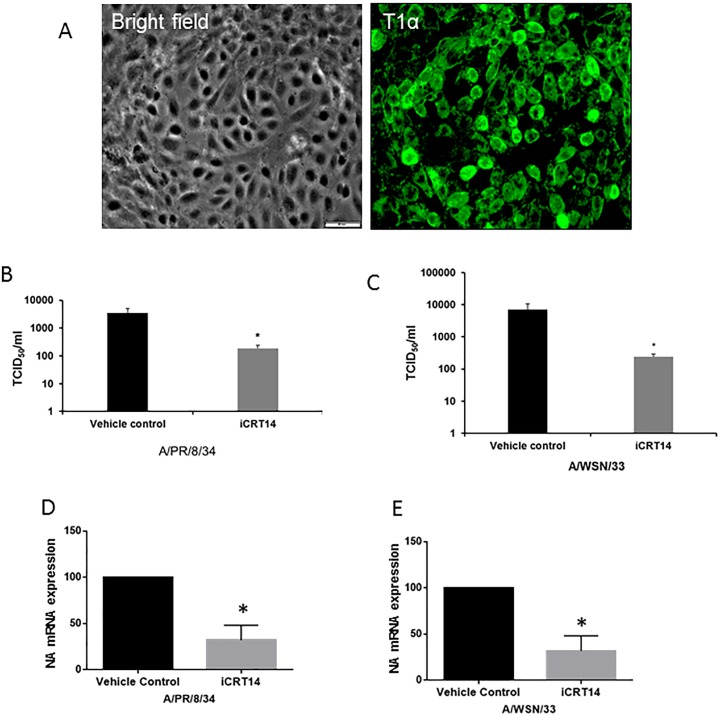
iCRT14 reduces influenza virus infection in primary mouse alveolar epithelial cells (AECs).Mouse AECs were isolated and cultured for 6 days. (A) AECs were immuno-stained with the AEC type I marker T1α and the nuclear dye DAPI. Scale bar = 50 μm. (B-E) AECs were infected with influenza virus A/PR/8/34 or A/WSN/33 at an MOI of 1 for 24 h. The cells were treated with iCRT14 (12.5 μM) or vehicle control 1 h prior to infection. Viral titers in the cell culture medium were determined using the TCID50 assay (B, C). NA mRNA levels in cells were determined by real-time PCR and normalized to GAPDH. The results of 3 independent experiments are displayed as the mean ± SE. *p<0.05 vs. vehicle control at the corresponding time points (Student’s t-test).